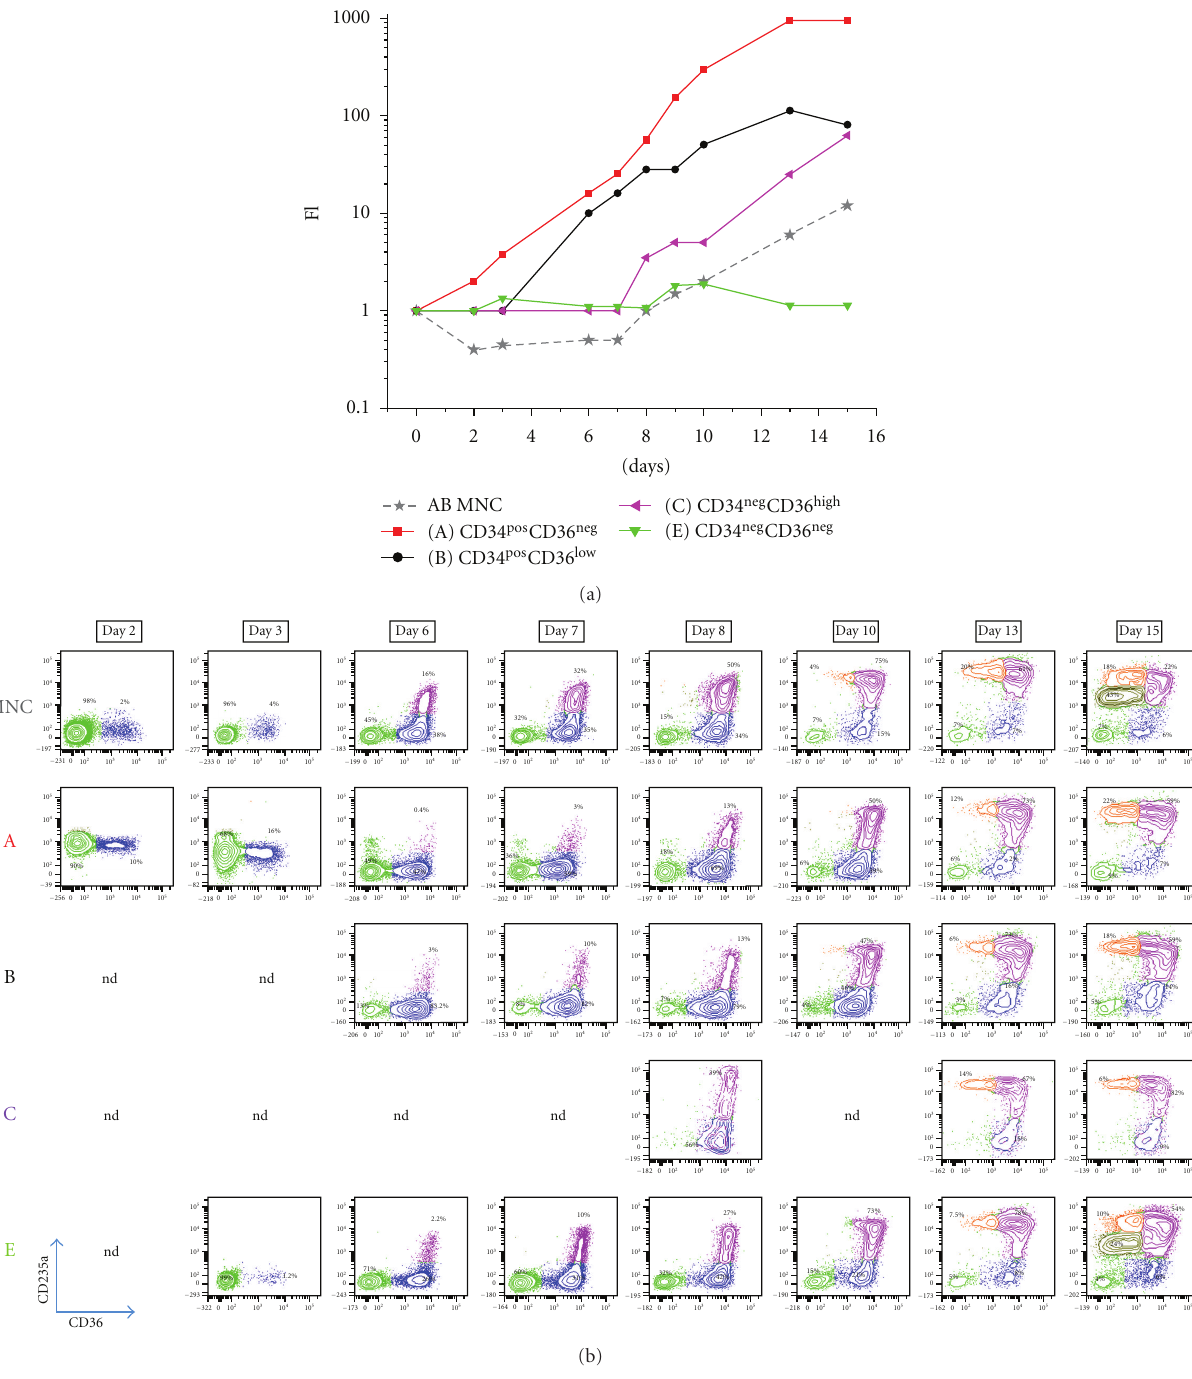
Figure 2: Growth and erythroid maturation of MNC prospectively isolated on the basis of CD34/CD36 profiling under HEMA conditions . (a) Growth curve of cells prospectively isolated from AB MNC under HEMA conditions (the same color code as in Figure 1). MNC (grey dotted line) were cultured in parallel as control. The number of cells present in the cultures is expressed as fold increase (FI). Results from a representative experiment are shown. Similar results were observed in 2 additional experiments (see also Table 1). (b) Time course of the maturation of EBs in HEMA cultures seeded with either AB MNC or with populations A, B, C, or E, as indicated. EBs maturation was defined on the basis of CD36/CD235a profiling which divides EBs into three populations: CD36 pos CD235a neg / low (proerythroblasts, blue); CD36 pos / CD235a med / high (basophilic erythroblasts, purple), and CD36 low CD235a high (orthochromatic erythroblasts, red). Forward and side scatter analyzes identified a fourth population of small CD36 low CD235a low cells, probably represented by pyrenocytes (yellow). Cells which do not express EB markers are indicated in green. The numbers within each quadrant indicate the frequency of the di ff erent subpopulations. Results are representative of those obtained in three independent experiments. nd = not done, due to low cell